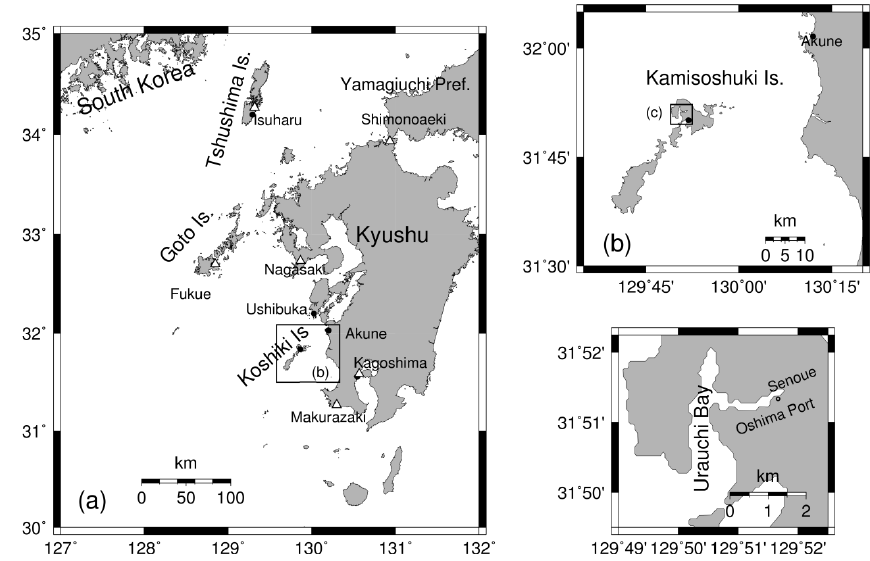
Fig. 1. Maps of the western Kyushu Islands (a) , Koshiki Islands (b) , and Urauchi Bay (c) of Kamikoshiki Island.